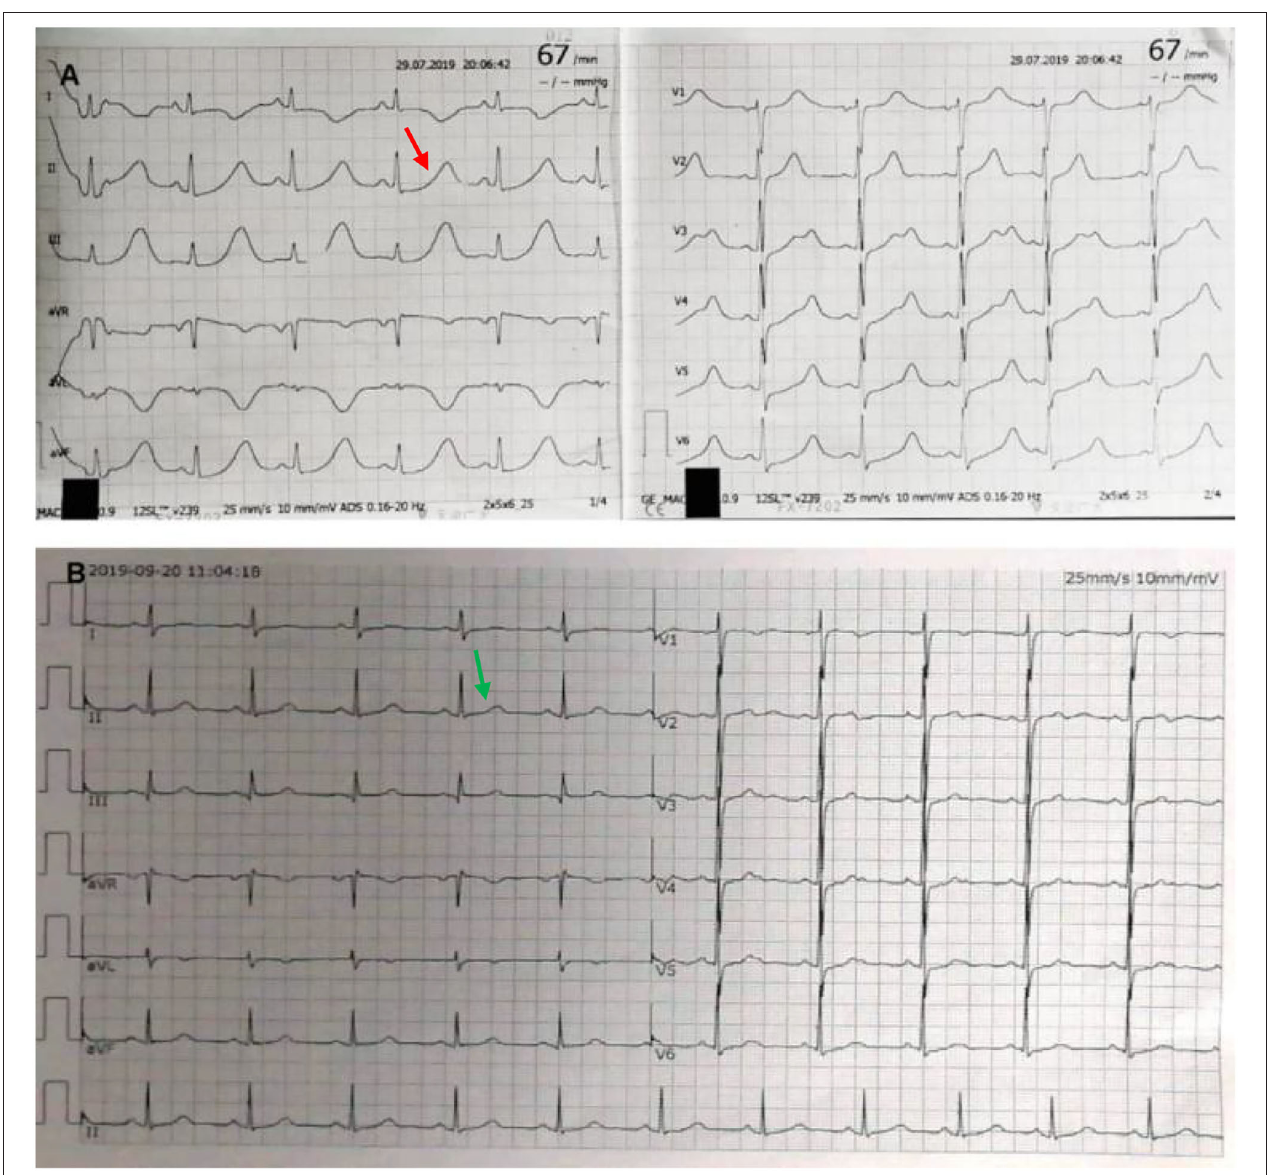
FIGURE 1 | Electrocardiograph (ECG). ECG at admission shows sinus rhythm and QTc interval of 661ms [ (A) red arrow]. After excision of pheochromocytoma, ECG shows normalization with QTc of 404ms [ (B) green